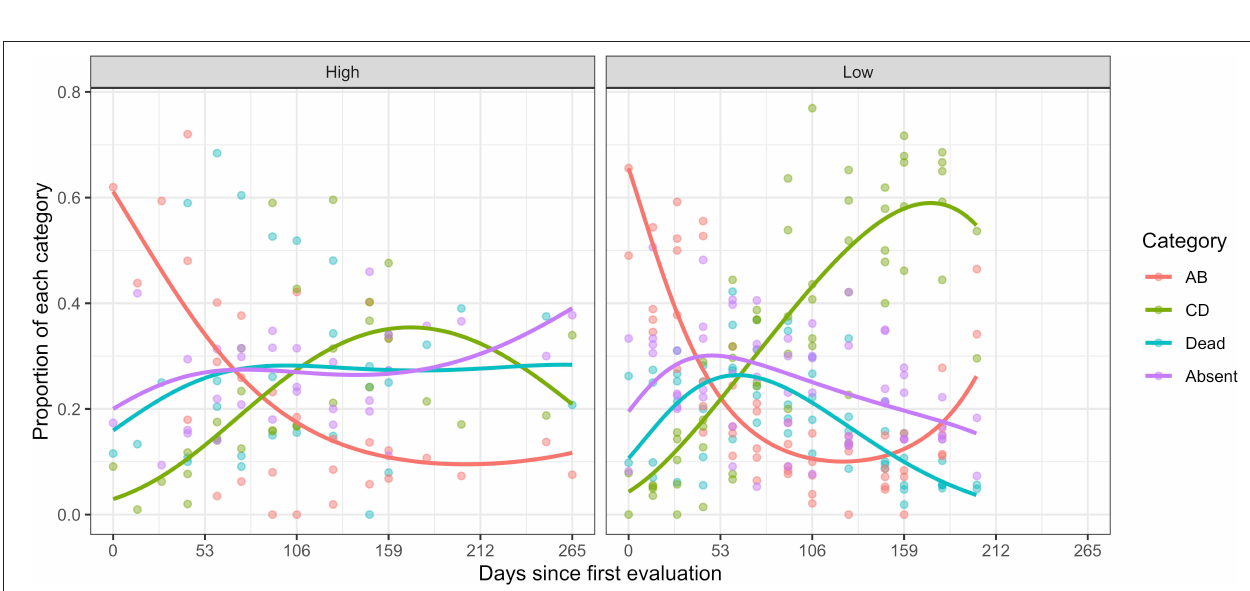
FIGURE 4 | Proportion of CBB-infected with B. bassiana from coffee farms in the Kona and Ka’u districts of Hawaii adopting calendar (high) and threshold (low) spray programs. Data points represent one observation, and curves are fitted means obtained using generalized binomial mixed models with linear and quadratic random effects over time.